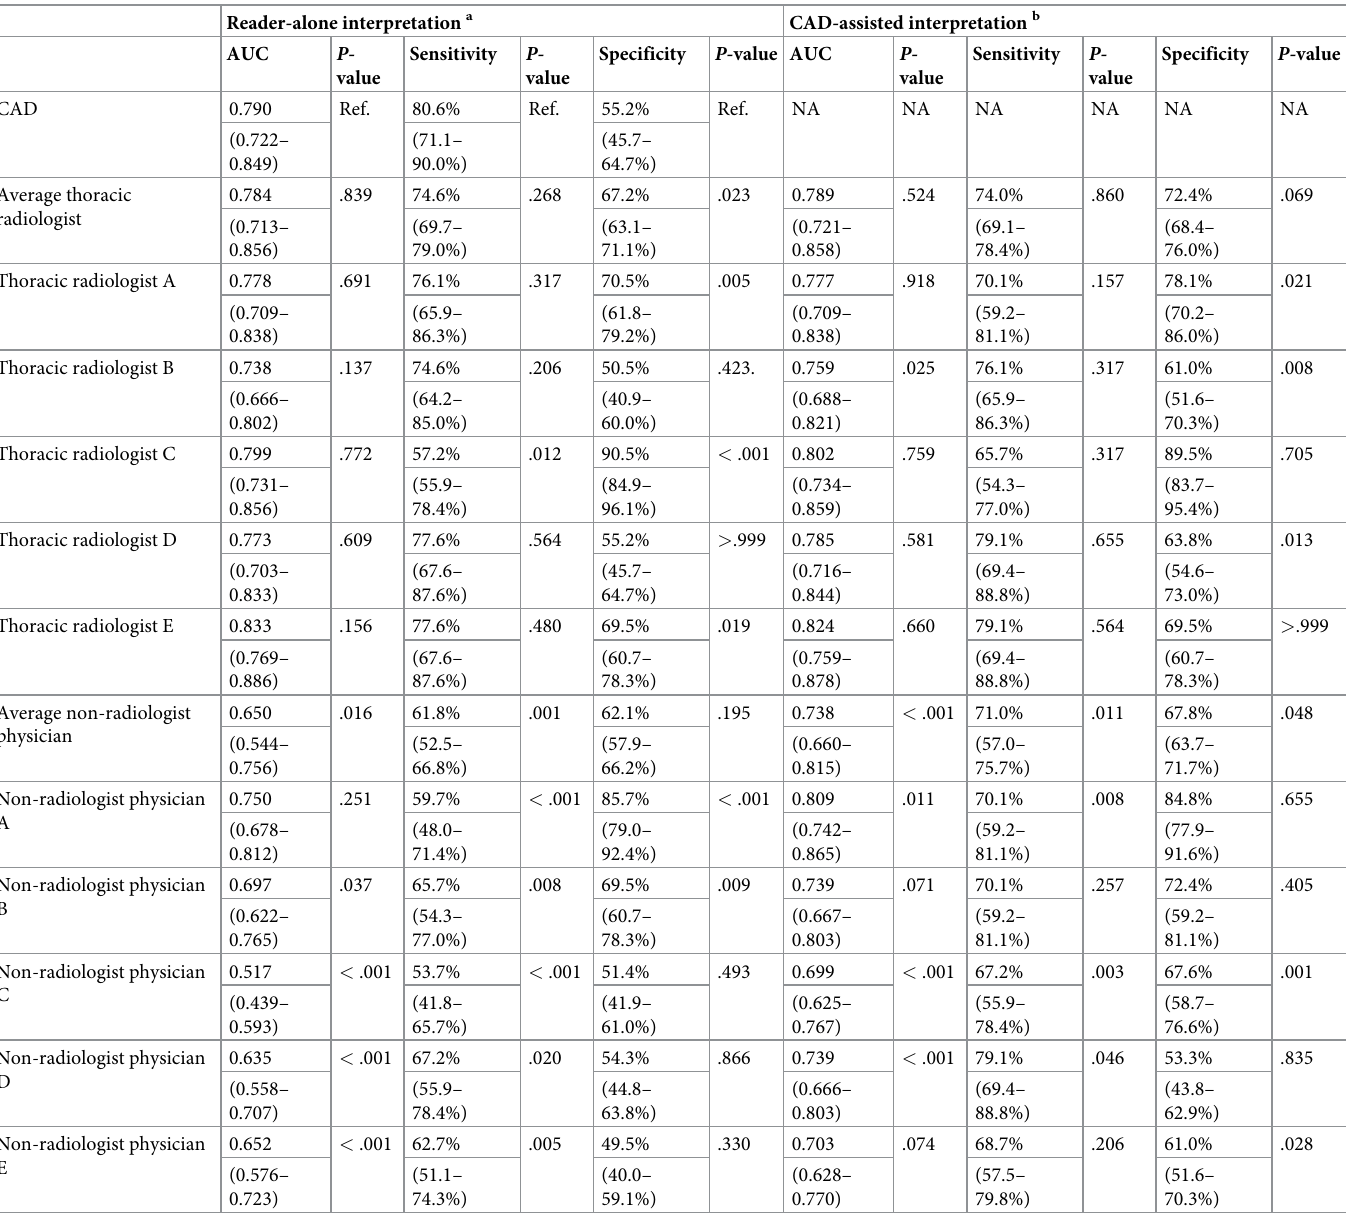
Table 3. The CAD and physician’s performances with reference standard of pneumonia on chest